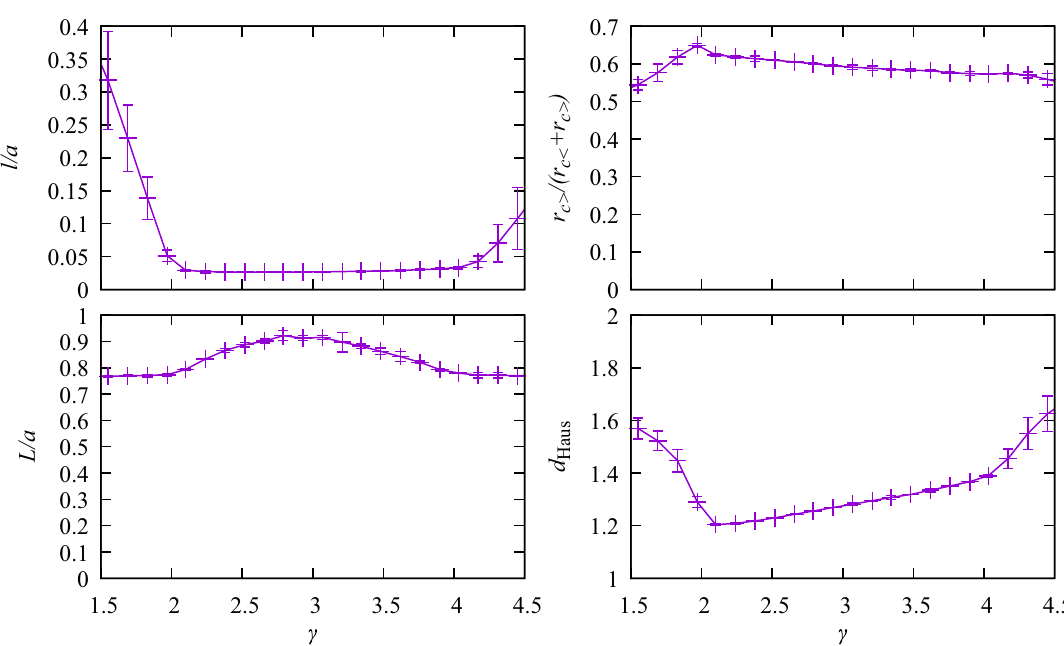
1 . Morphological properties ∼